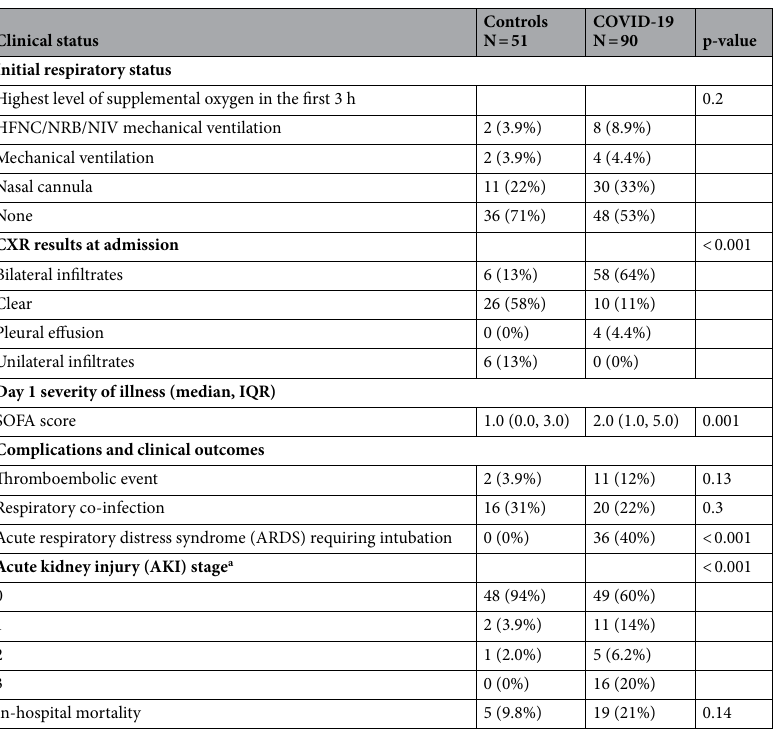
Table 3. Severity of Illness and outcomes of COVID-19 patients and controls. AKI was defined according to KDIGO guidelines 21 . ARDS was defined according to the Berlin Definition 22 . HFNC High-flow nasal cannula, NRB non-rebreather mask, NIV non-invasive, CXR chest X-ray, SOFA sequential organ failure assessment. a Patients with end stage renal disease who were on dialysis prior to admission were